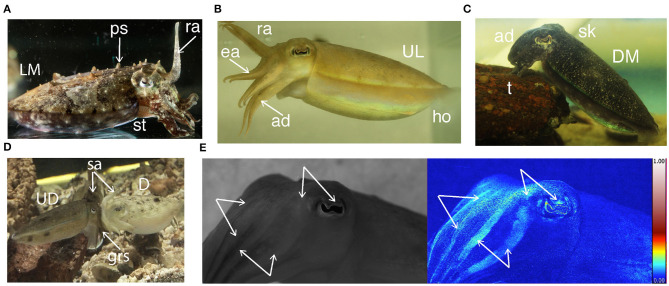
Some of the body patterns of S. plangon. (A) Male with raised arms (ra), papillate skin (ps), sitting (st), and light mottle (LM). (B) Female. Hovering (ho), raised I arms (ra), extended II and III arms (ea), dropped arm (ad), and uniform light (UL) pattern. (C) Female in tripod posture (t), dropped arms (ad), smooth skin (sk), and dark mottle pattern. (D) Female and male in head-to-head mating position with splayed arms (sa), male grasping (grs), uniform darkening (UD), and deimatic pattern (D). (E) Male cuttlefish. The white arrows refer to polarized arm stripes and polarized eye sclera. The blue-red scale bar represents the percentage of polarization from 0 (blue) to 1 (white) through (red) which is typical for polarization in nature.